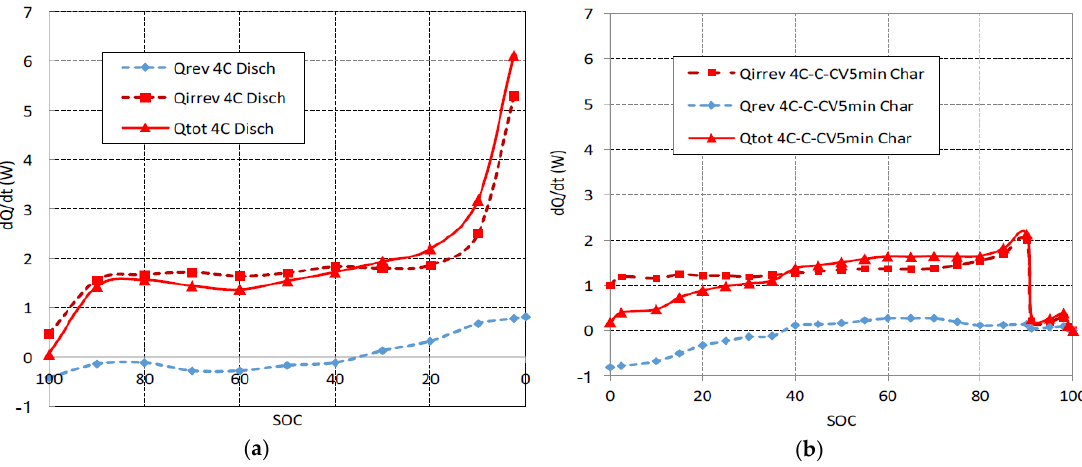
Figure 3. ( a ) Reversible component of heat, irreversible component of heat and total heat evolution profile versus state of charge of the cell, 4C discharge; and ( b ) 4C-1C-CV 5 min charge.